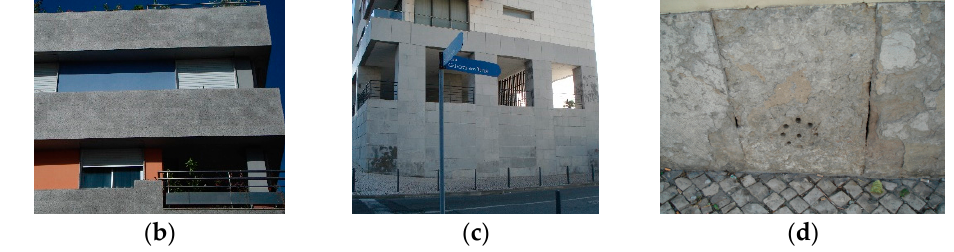
Figure 2. General appearance of NSC in the different degradation conditions: ( a ) condition A ( S w ≤ 1%); ( b ) condition B (1 < S w ≤ 8%); ( c ) condition C (8 < S w ≤ 20%); ( d ) condition D (20 < S w ≤ 45%).